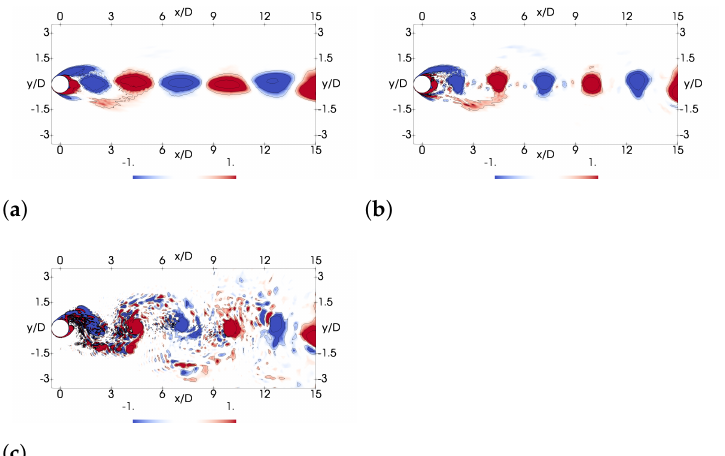
Figure 10. Instantaneous vorticity isocontours for a flow reconstructed with ( a ) 2 modes; ( b ) 10 modes; and ( c ) all